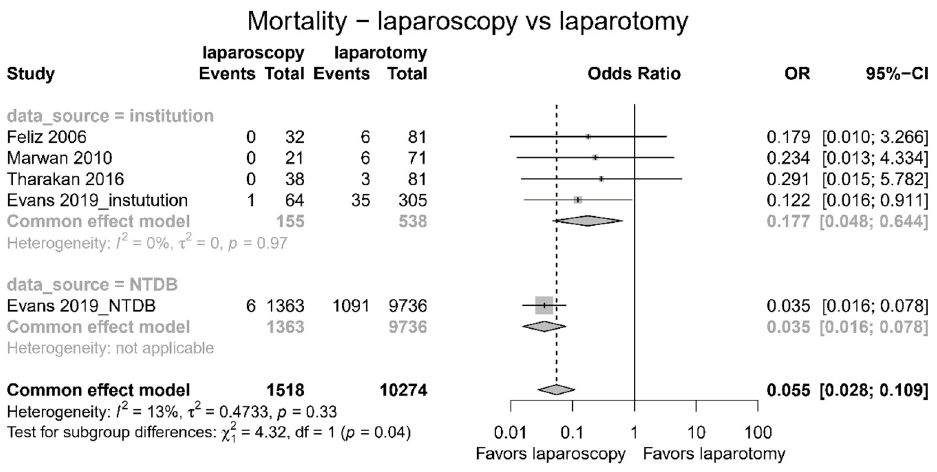
Figure 3. Morbidity and mortality (laparoscopy versus laparotomy). ( a ) Hospital stay, ( b ) compli- cations, and ( c ) mortality.